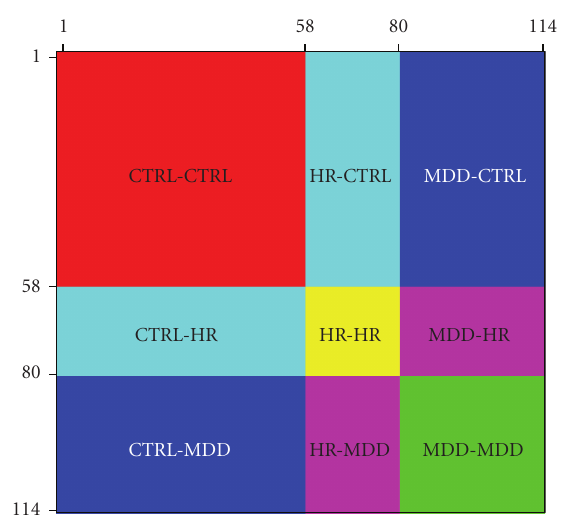
Figure 1: Structure of the interpoint comparison matrices D for the 114 subjects.